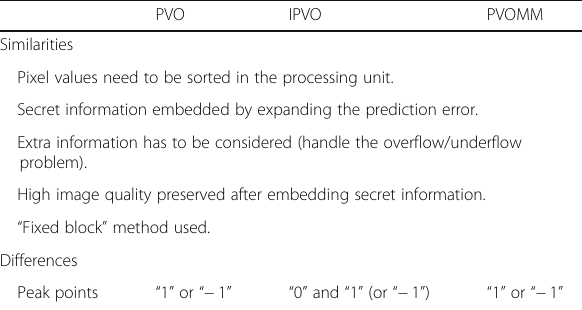
Table 2 Similarities and differences points among the three PVO-based methods [25]